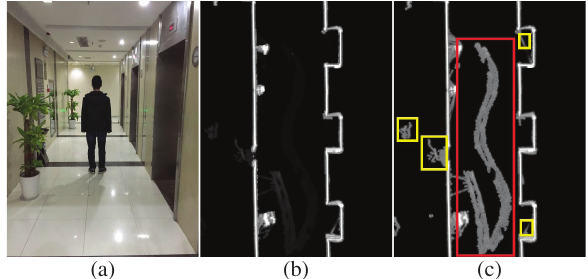
Figure 7: Comparative results of different likelihood updating strategies in an indoor office corridor with a walking pedestrian: (a) a scene photo; (b)-(c) the last likelihood maps with our proposed learning strategy with decreasing and without it, respectively. Brighter intensities indicate higher likelihood values.